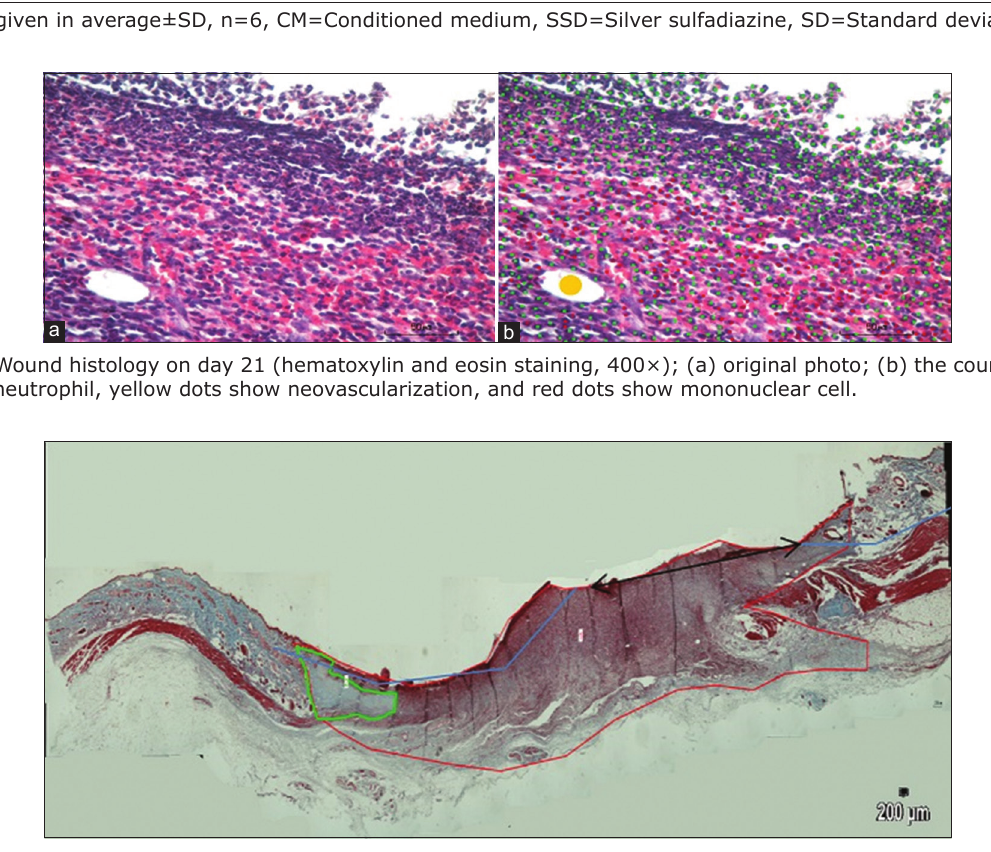
Figure-5: Wound histology on day 21 (Masson’s trichrome staining, 40×, pictures were combined using software PTGui (Pro software by New House Internet Service B.V; Rotterdam, the Netherlands); red line shows the wound area; green line shows collagen area; two-headed arrow shows the edges of re-epithelization